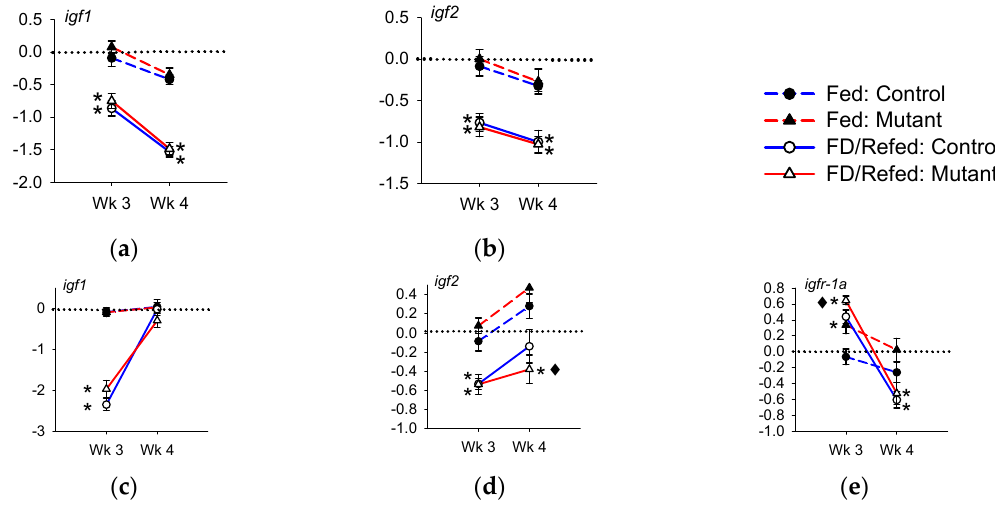
Figure 5. Expression of igf1 , igf2 , and igfr-1a in liver ( a , b ) and white muscle ( c , d , e ) during feed deprivation and refeeding. The y-axis represents gene expression values in arbitrary units normalized to the continuously fed control group from Wk 3 and expressed as log 2 (fold change). The horizontal dotted line is a visual reference for log 2 (fold change) = 0. Asterisks indicate that the feed-deprived (FD, Wk 3) or refed (Wk 4) groups (solid line) differ from continually fed fish (dashed line) within the same treatment group and week ( p < 0.05, n = 21). The black diamond indicates that the fold change differs between the mutants and controls.